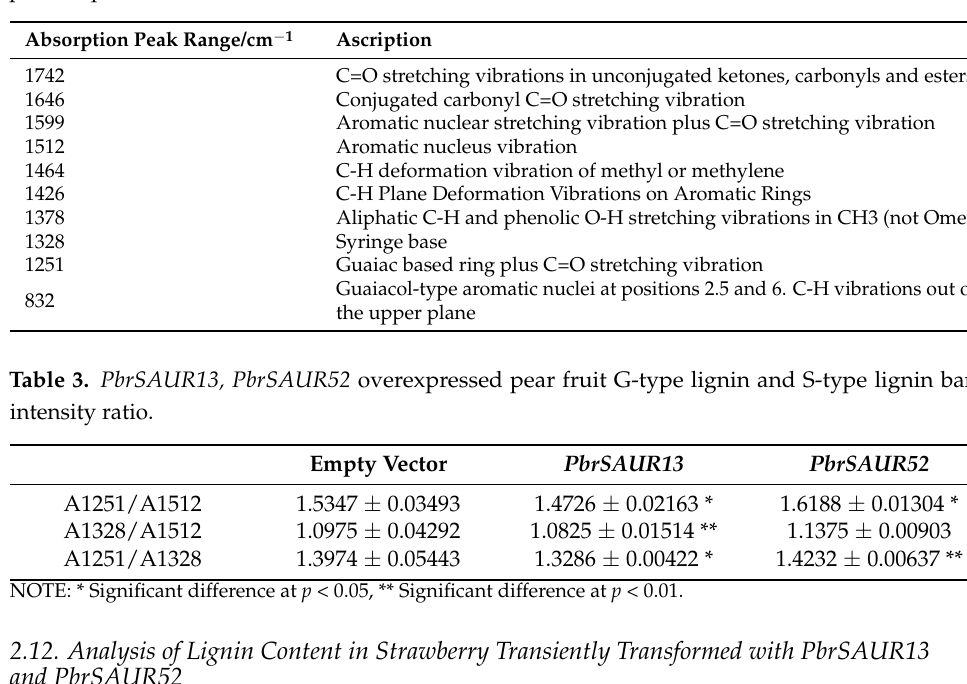
Table 2. Infrared spectrum characteristic peaks and attribution of lignin in PbrSAUR13,52 overex- pressed pear fruit.